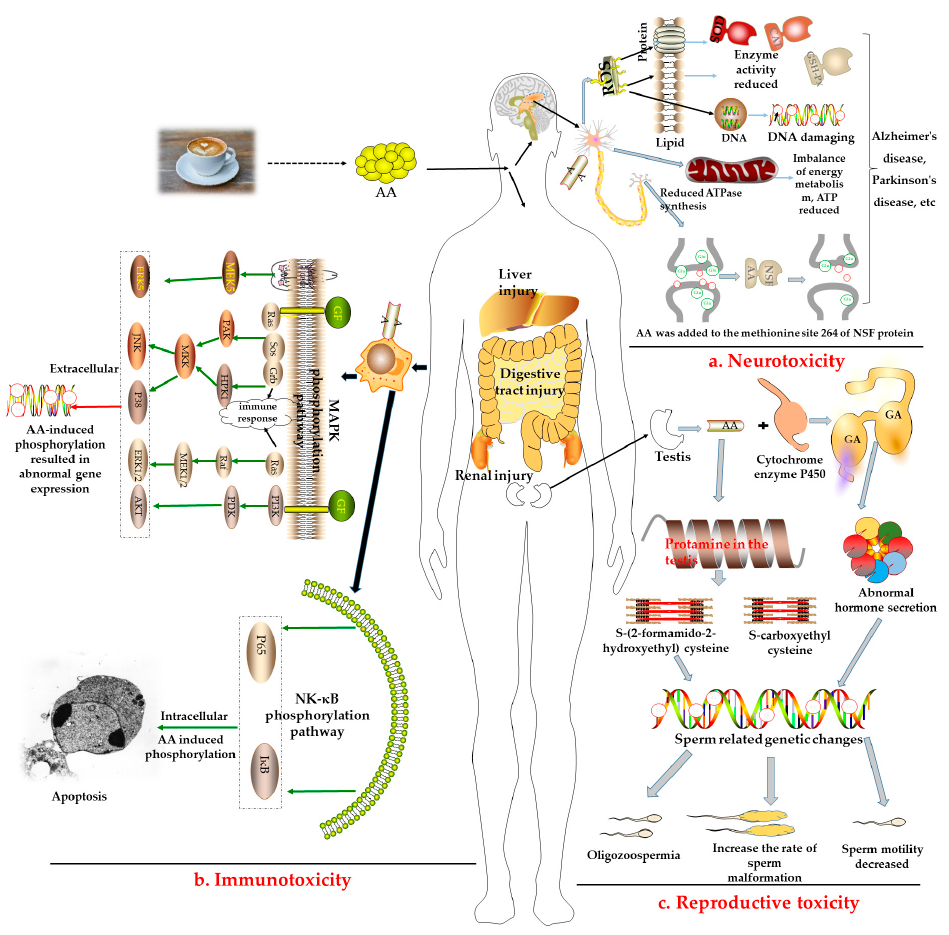
Figure 2. Mechanisms of AA-induced Figure 2 . Mechanisms of AA-induced toxicity.